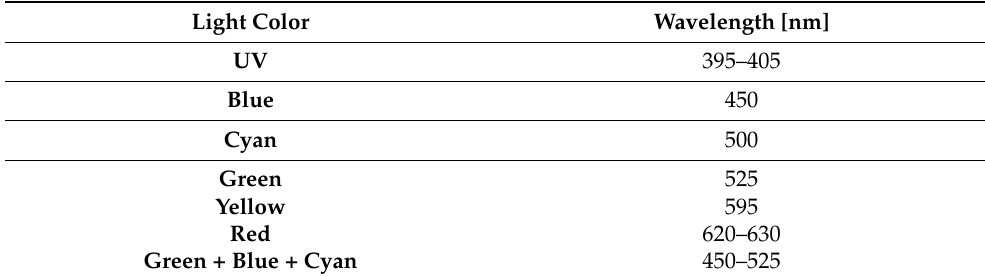
Table 3. Wavelength values for selected colors of visible